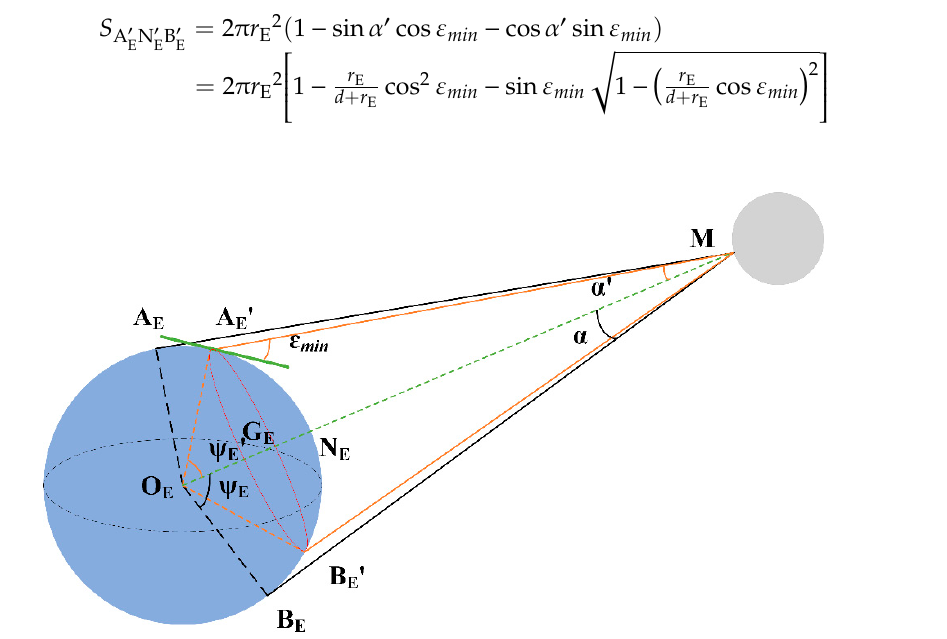
Figure 2. Earth spherical cap observed from a Moon-based sensor.